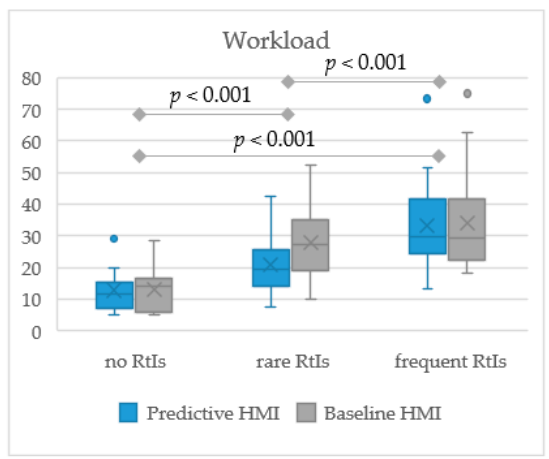
Figure 6. Boxplots for workload (NASA-RTLX).